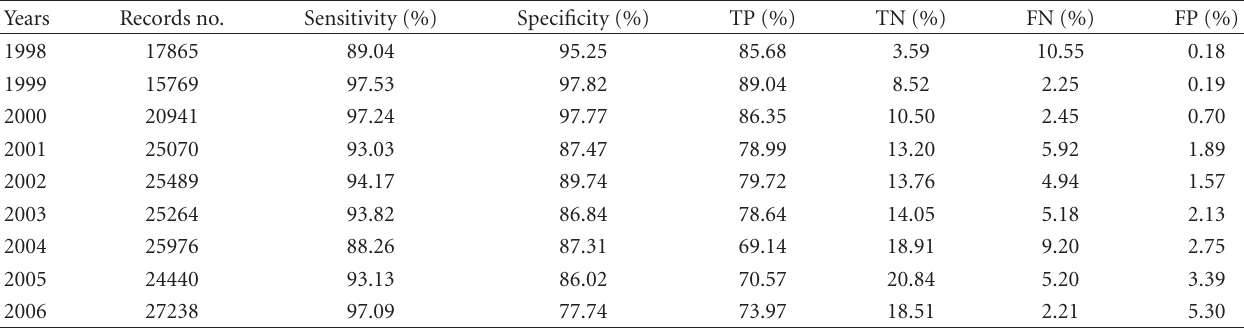
Table 1: Assessment of the linkage procedure: sensitivity, specificity, rates of true positives (TP), true negatives (TN), false negatives (FN), and false positives (FP), for each